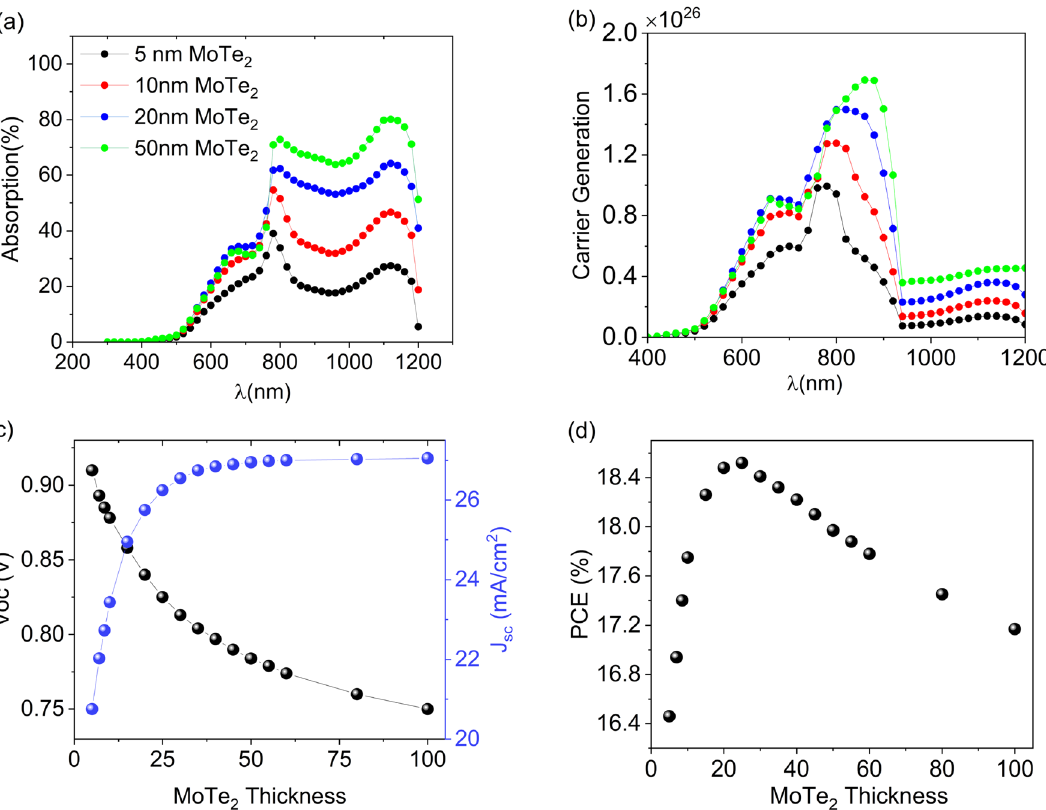
Figure 3. The multijunction PSC performance dependance on MoTe 2 thickness. ( a ) The absorption spectra of the MoTe 2 film with different thicknesses. ( b ) The carrier generation inside the different thicknesses of the MoTe 2 layer. ( c ) The black and blue curves represent the dependence of V OC and J SC on MoTe 2 thickness, respectively. ( d ) The dependance of PCE on MoTe 2